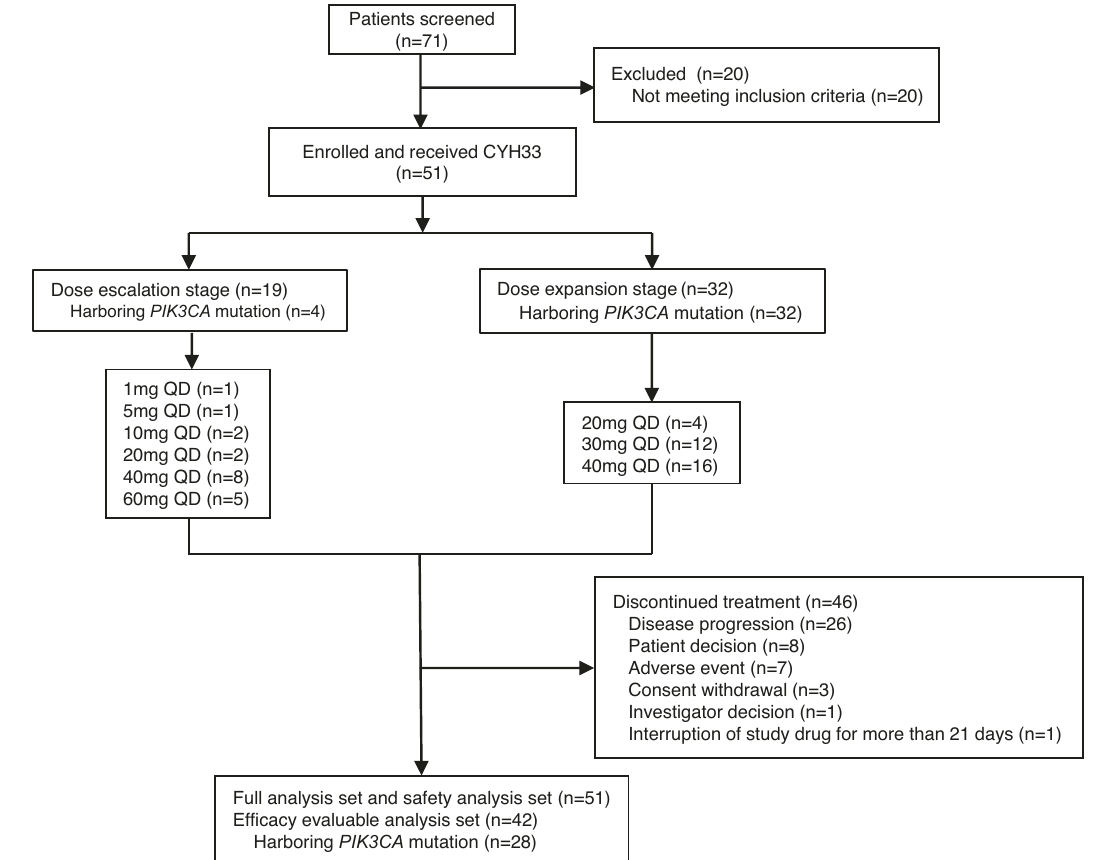
Fig. 1 | Trial pro fi le. Diagram indicating participant numbers and disposition through the course of the trial. QD, once